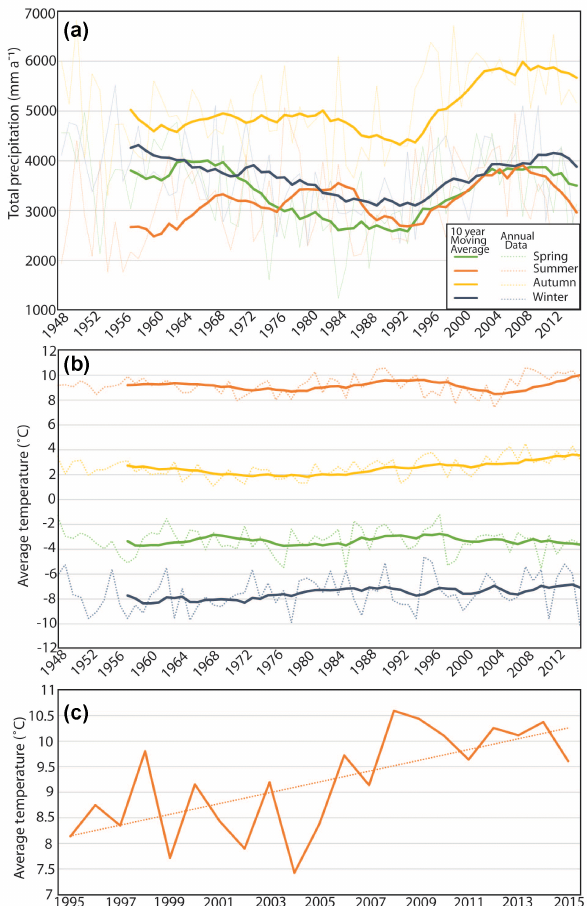
Figure 6. Climatic variation on the Kamchatka Peninsula between 1948 and 2015, derived from NCEP/NCAR daily reanalysis figures averaged across the whole peninsula (see Kalnay at al., 1996). (a) Seasonal precipitation record. (b) Average seasonal temperature. (c) Summer temperature record from 1995 to